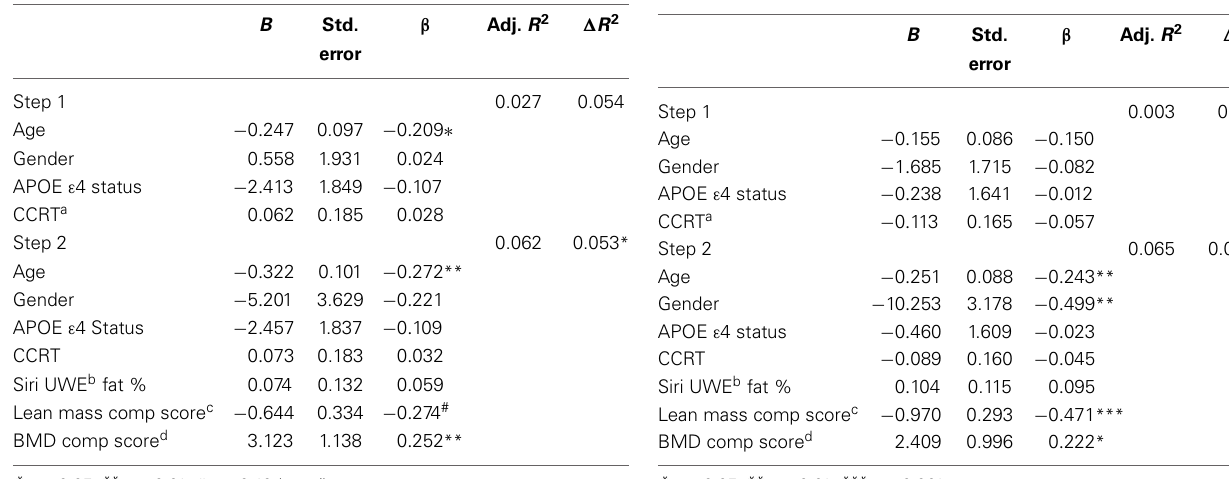
Table 4 | Hierarchical linear regression predicting baseline CVLT List A trials 1–5 total score from lean mass and bone density composite scores.